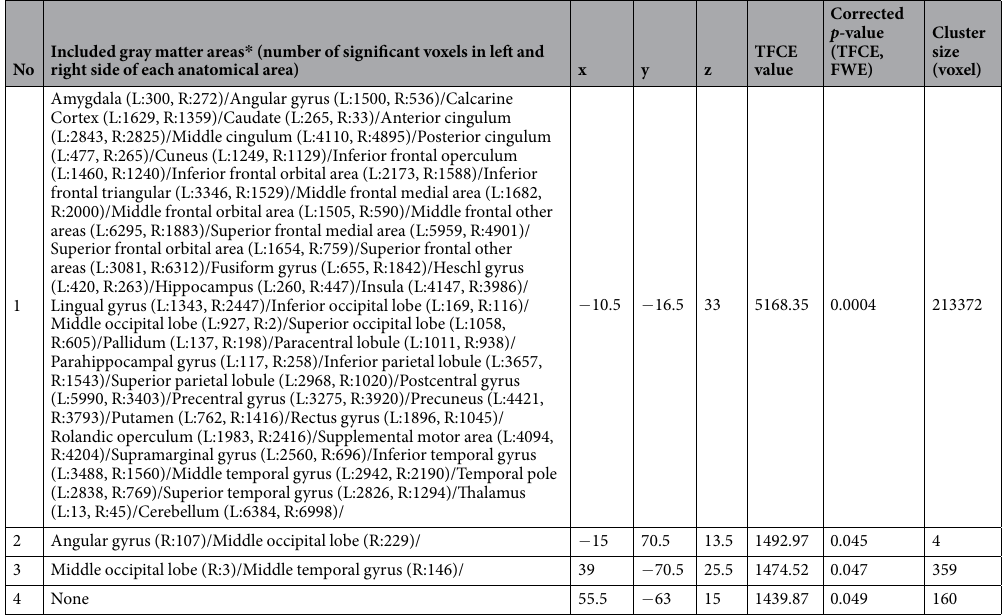
Table 4. Brain regions exhibiting significant correlations between Stroop interference and